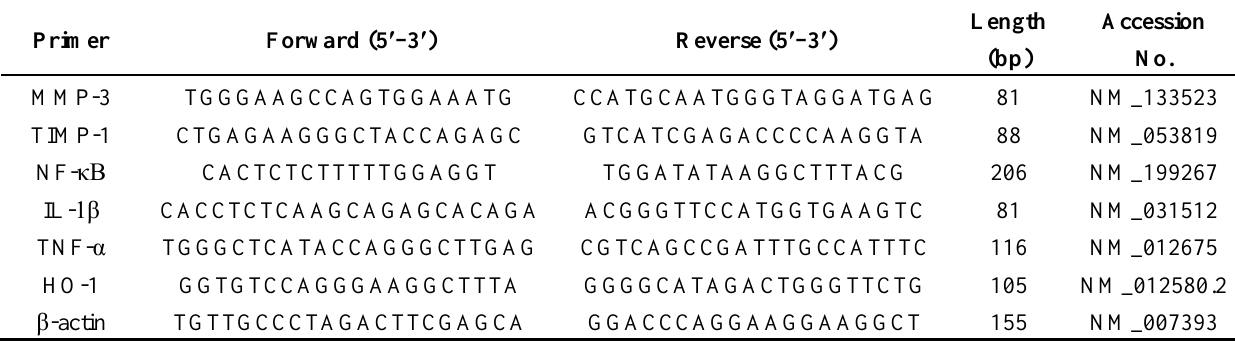
Table 1. Primer sequences used in this